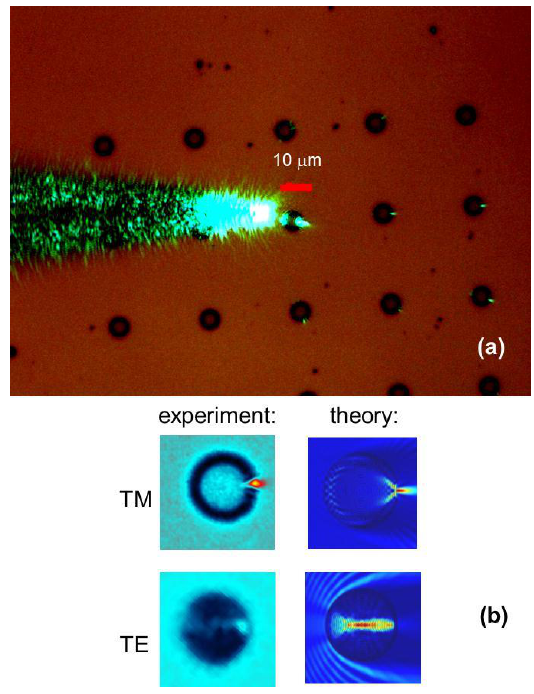
Figure 2. ( a ) Focusing behavior of the fabricated array of 6  m diameter Luneburg lenses for TM polarized light. Additional white light illumination was used to highlight lens positions. ( b ) Digital zoom of the measured field distributions inside the Luneburg lens